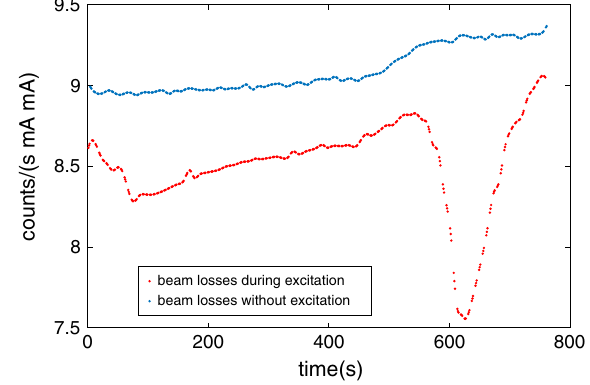
FIG. 7. The red line represent the loss rates during the excitation. The blue line corresponds to the loss rates that happen when the excitation is paused and any betatron resonances have damped out. The data are plotted versus the time to show the sequence of excitation and nonexcitation during the measurement.